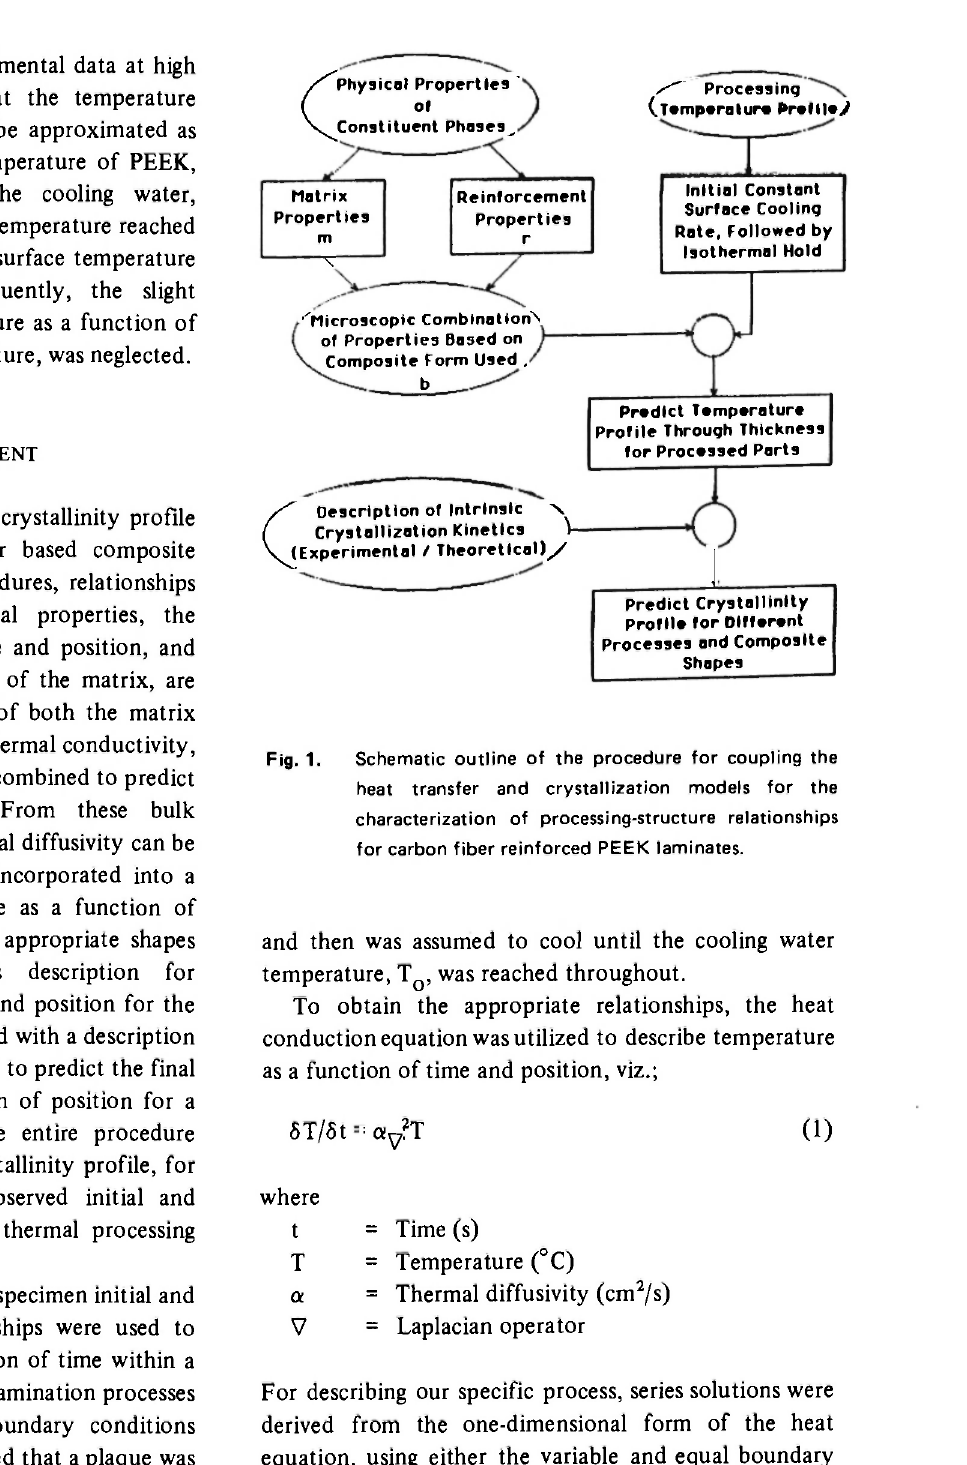
Schematic outline of the procedure for coupling the heat transfer and crystallization models for the characterization of processing-structure relationships for carbon fiber reinforced P E EK